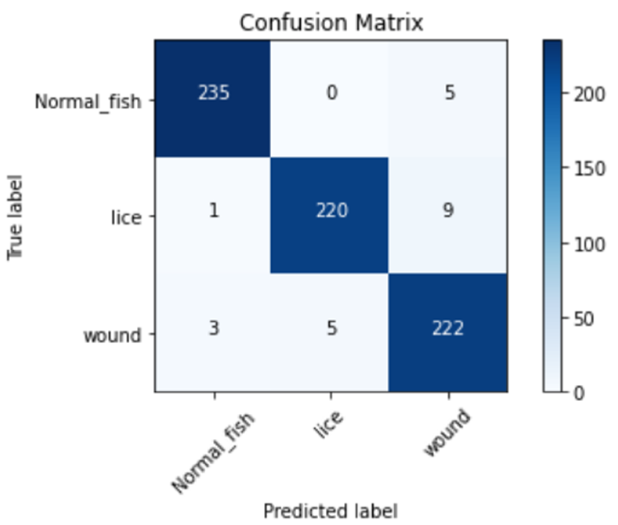
Figure 6. The accuracy and loss in the testing and training datasets over 400 iterations. The confusion matrix (True label and Predicted label) is plotted based on the obtained output for the proposed CNN model. The confusion matrix can be found in Figure 7. Here, normal fish are referred to as healthy fish.